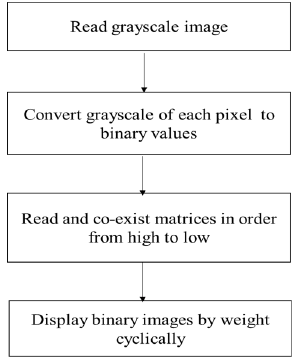
Figure 4. Flow chart of grayscale generation algorithm.